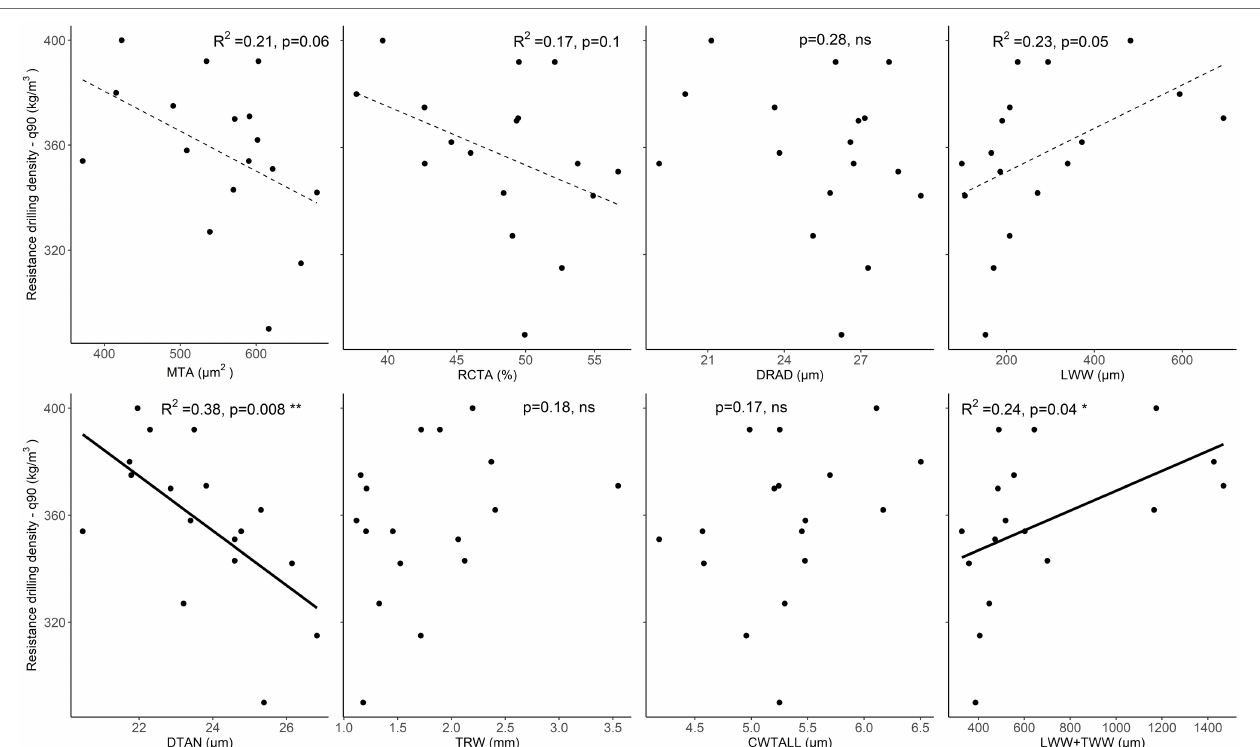
FIGURE 7 | Relationships between maximum resistance drilling density (90th quantile) values and wood-anatomical features (MLA—mean lumen area, RCTA— relative conducting area, DRAD—radial lumen diameter, LWW—latewood width, DTAN—tangential lumen diameter, TRW—tree-ring width, CWTALL—cell wall thickness, and TWW + LWW—the total width of transition wood and latewood) in spruce. The weak relationship ( p < 0.1) between wood-anatomical features and resistance drilling density is marked with a dotted line, while significant relationships ( p < 0.05) are shown by a full line. Further statistical information for the presented linear models is given in Supplementary Table 5